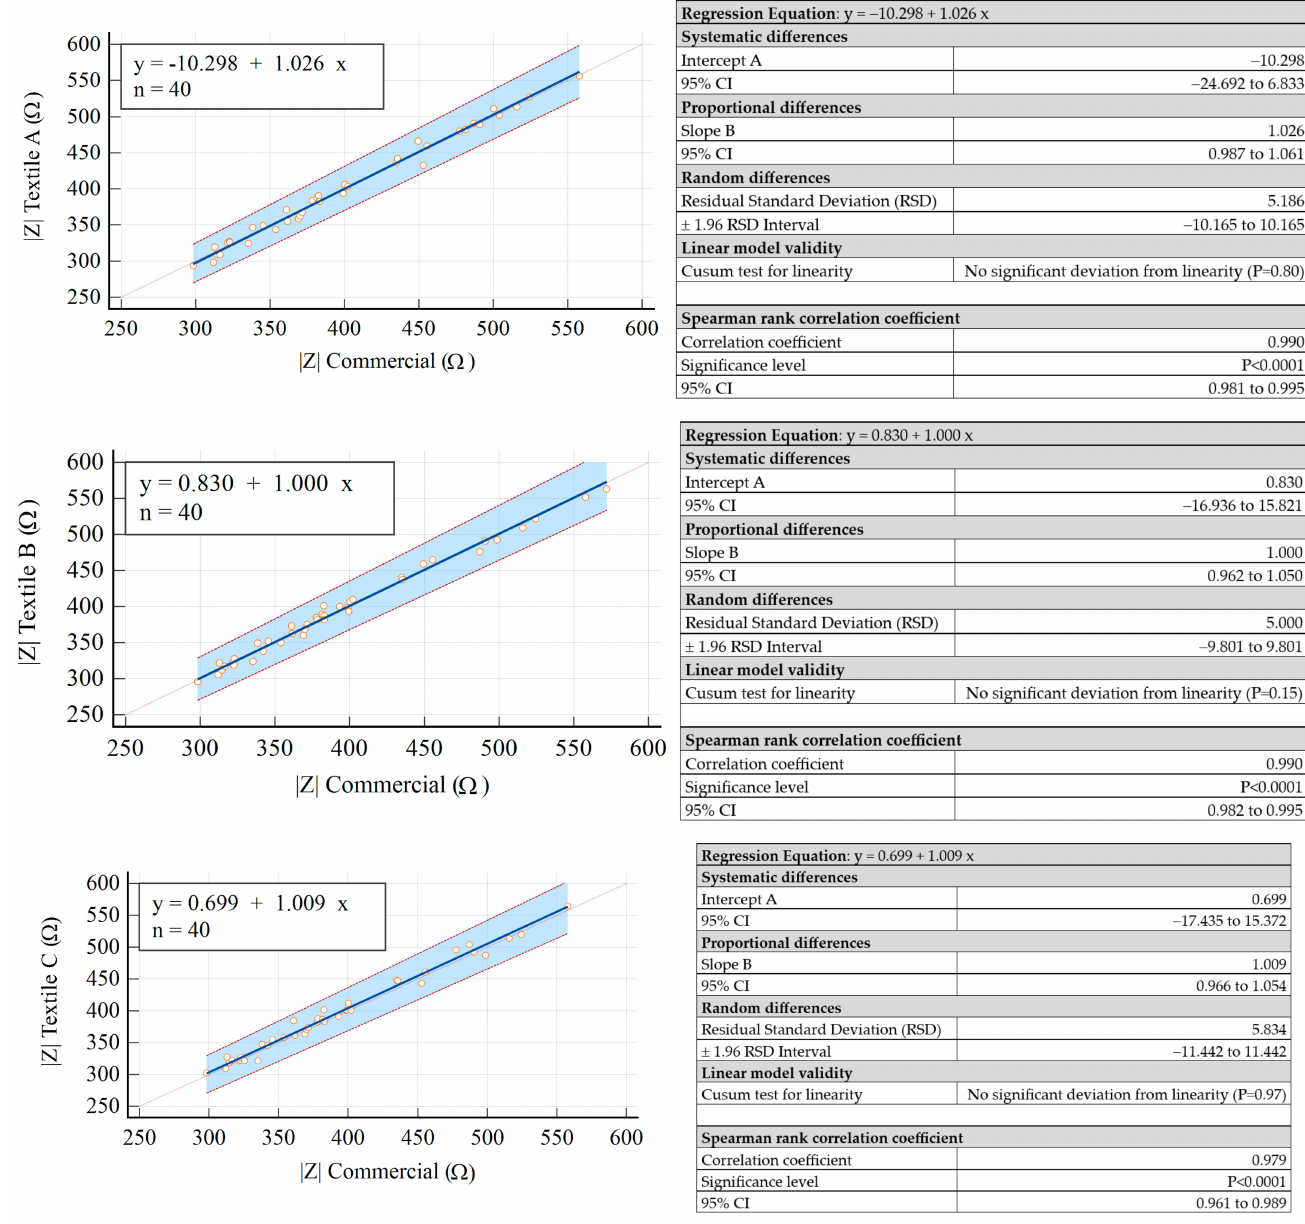
Figure 5. Passing–Bablok regression analysis results obtained for | Z |. The thin dotted line is the line for identity (y = x) while the thick blue line is the line for best fit. The red dashed lines indicate the 95% confidence